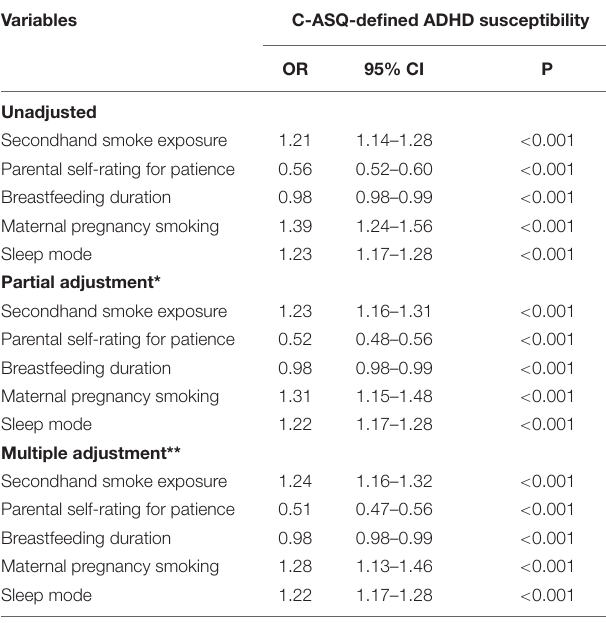
TABLE 2 | Risk prediction of five significant factors for C-ASQ-defined ADHD susceptibility.